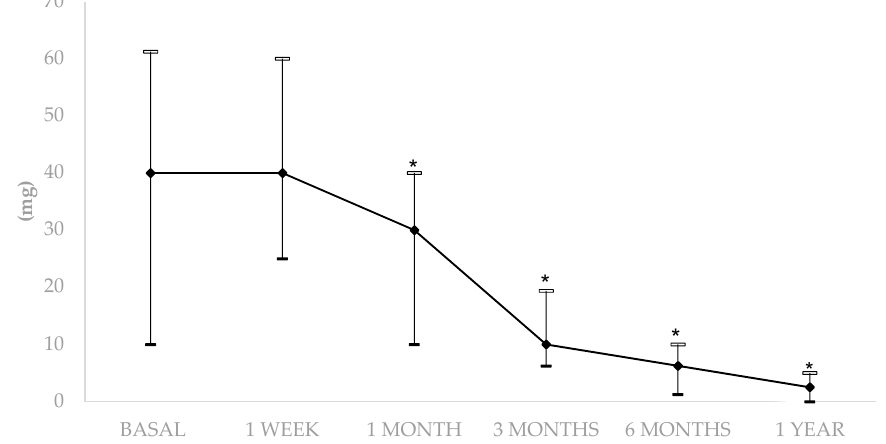
Figure 3. Glucocorticoid sparing effect of biologic therapy in refractory non-Multiple Sclerosis Optic Neuritis. * p < 0.05 compared with basal data.